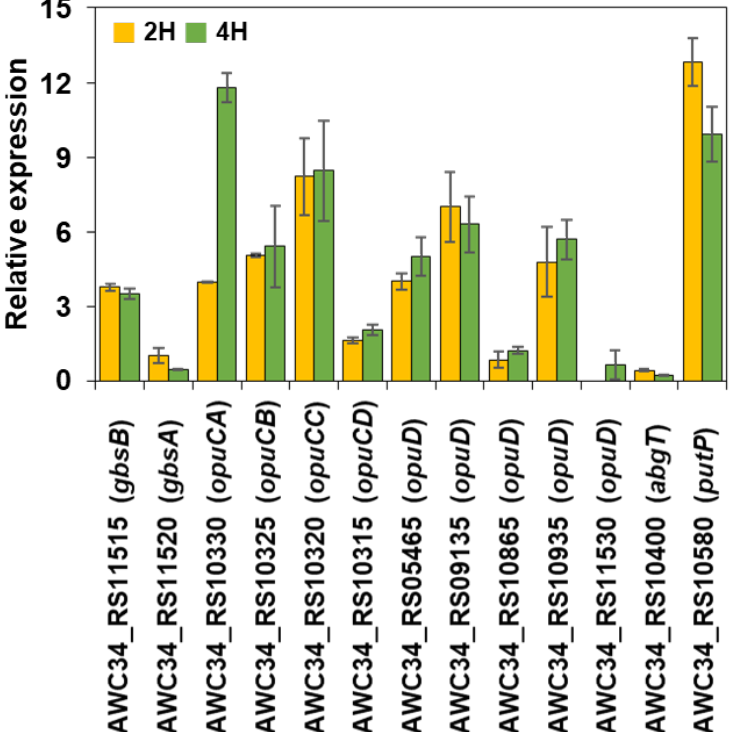
Figure 5. Validation of RNA sequencing data by quantitative real-time PCR. Genes expected to be related to resistance to salt were selected for validation. Data are expressed as log2 (fold-change) in gene expression between control and salt-treated samples. In qRT-PCR, 16S rRNA gene expression was used for normalization of target gene expression.